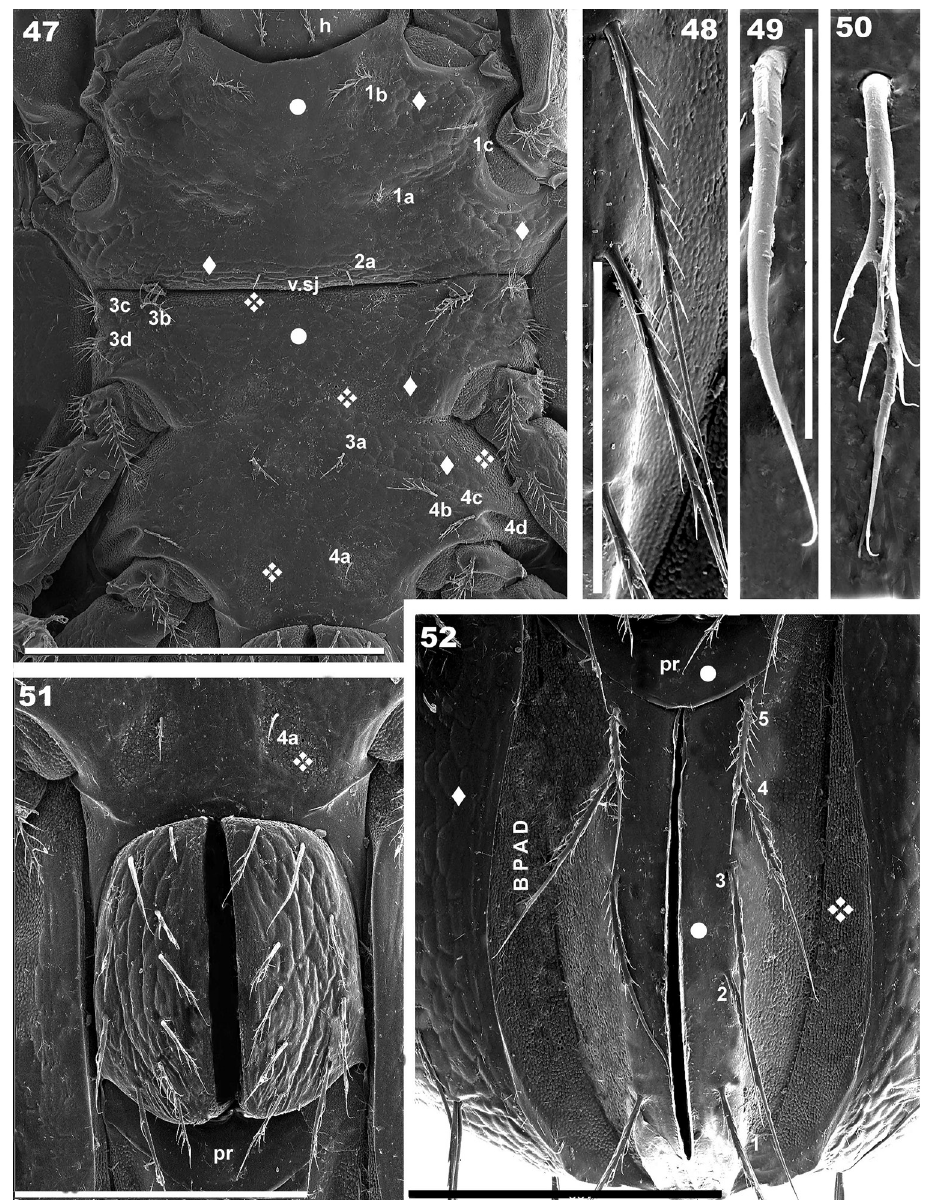
Figures 47–52. Torpacarus eidikoterai sp. n. Adult female with cerotegumental layer. SEM micrographs. 47 epimeral zone 48 adanal setae 49 genital setae, variation 50 genital setae 51 genital plate 52 ano- genital zone. Scale bars: 200 μm ( 47 ); 50 μm ( 48 ); 7 μm ( 49 ); 7 μm ( 50 ); 100 μm ( 51 ); 100 μm ( 52